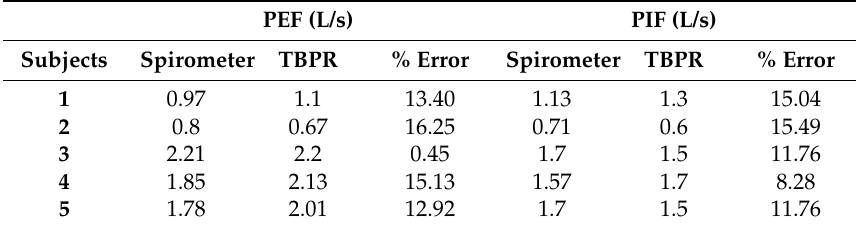
Table 3. Comparison of PIF and PEF computation with a spirometer and our TBP